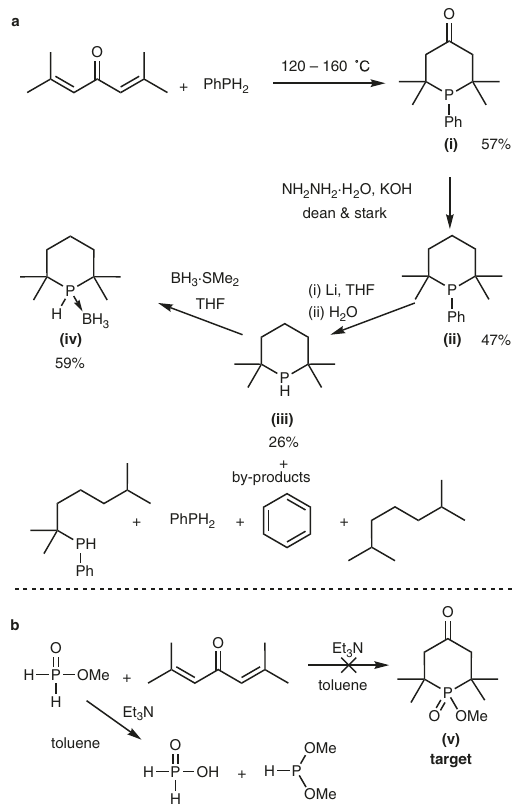
Fig. 3 Initial attempts to isolate TMPhos. a Synthesis of TMPhos via Li cleavage of 1-phenyl-2,2,6,6-tetramethylphosphinane. b Attempted synthesis of (v)